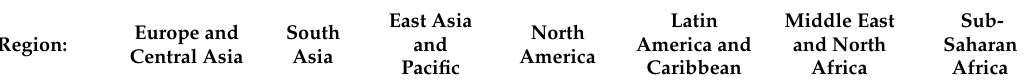
Table 9. Water type distribution ranking of water-related article records by primary and secondary